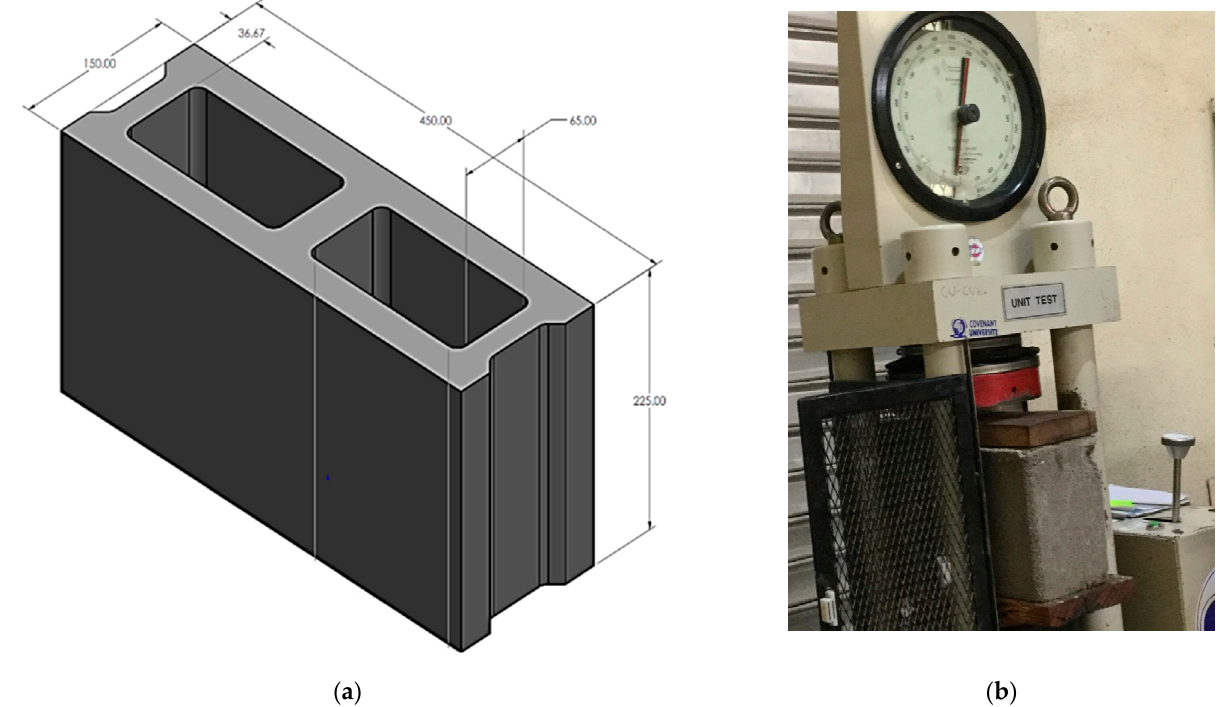
Figure 2. ( a ) Hollow sandcrete block; ( b ) compression test on block sample.